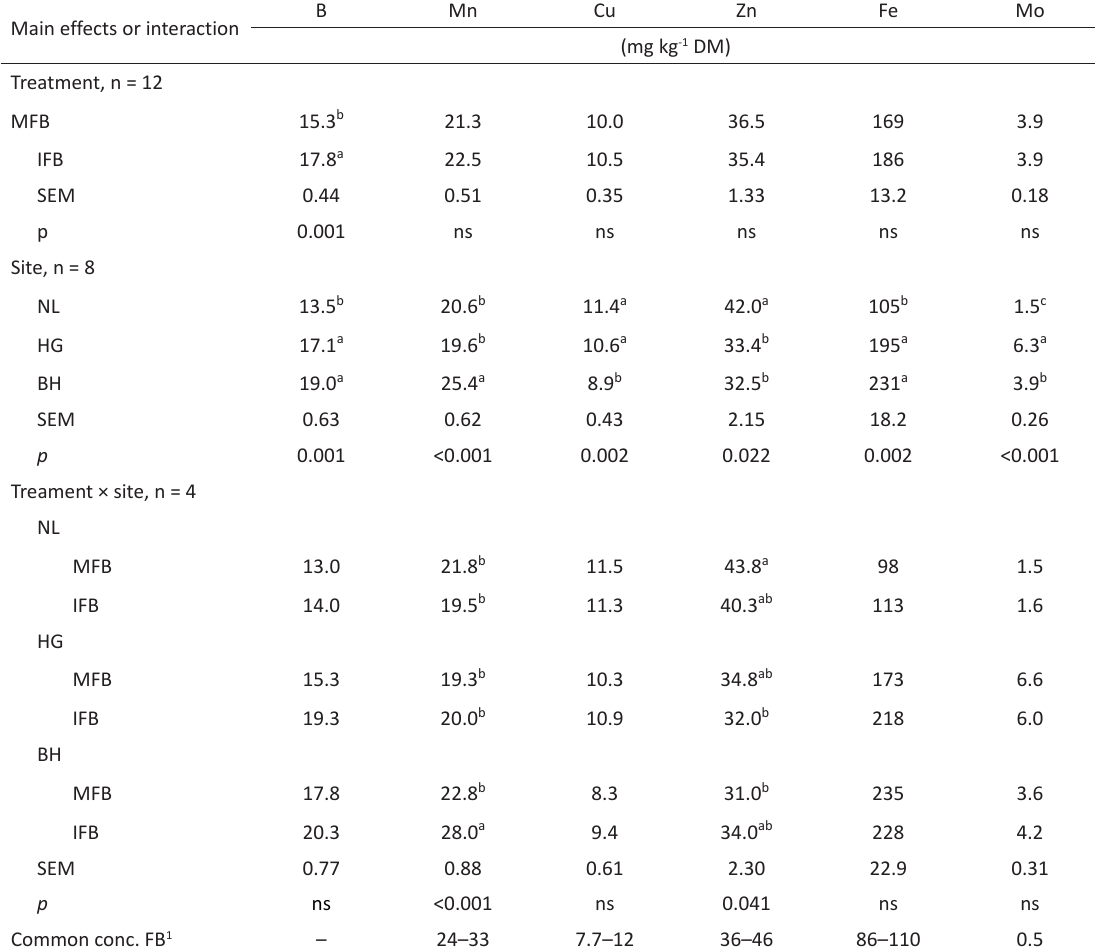
Table 3. Concentrations of micro nutrients in intercropped and monocropped faba bean in three field experiments Main effects or